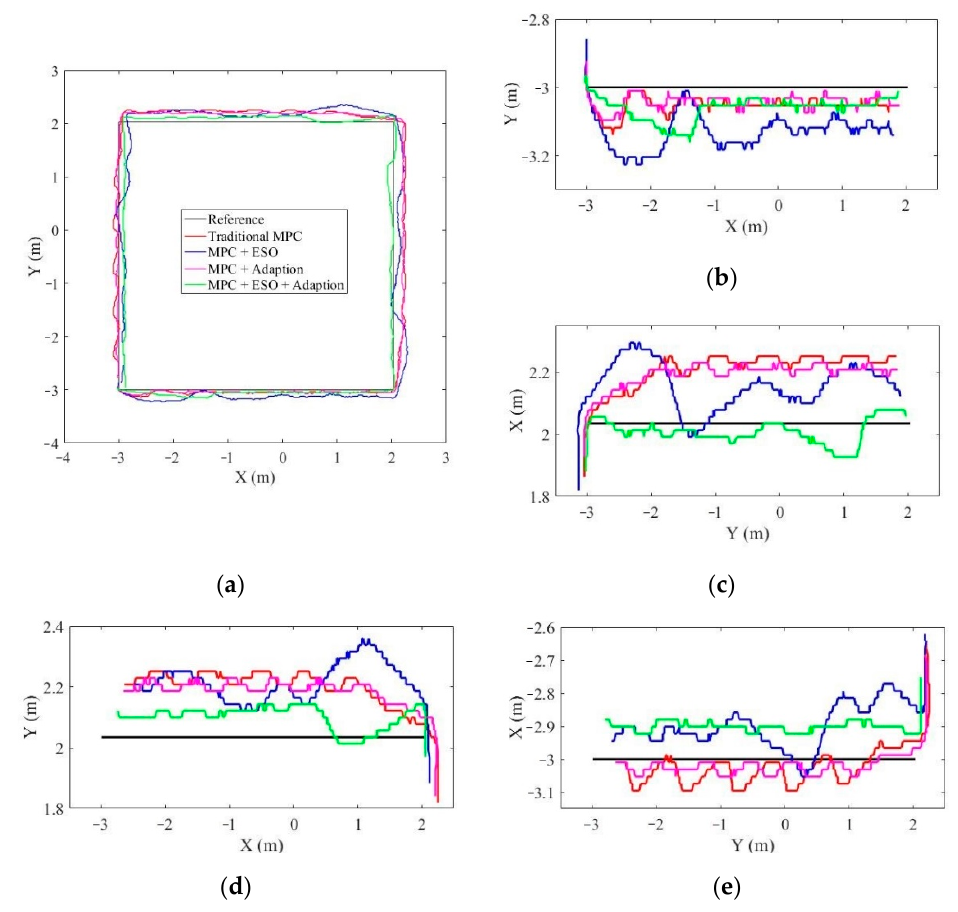
Figure 13. The trajectory of the robot when the disturbance velocities were u = 0.1 m/s and v = 0.1 m/s. ( a ) The overall trajectory; ( b ) The trajectory from − 3 m to 2 m in the X direction; ( c ) The trajectory from − 3 m to 2 m in the Y direction; ( d ) The trajectory from 2 m to − 3 m in the X direction; ( e ) The trajectory from 2 m to − 3 m in the Y direction.